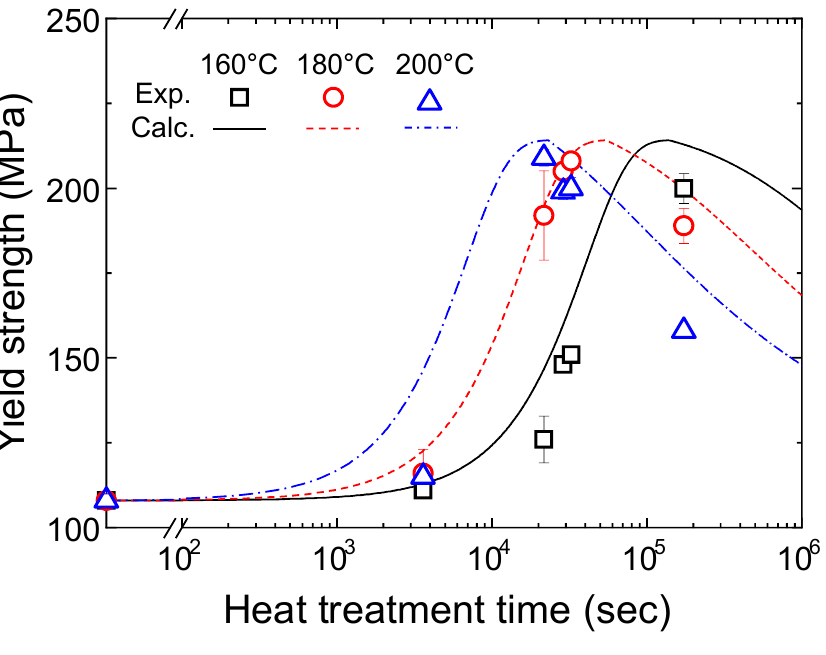
Figure 12. Calculated yield strength changes during T5 heat treatment compared with experimental data obtained in the present study.